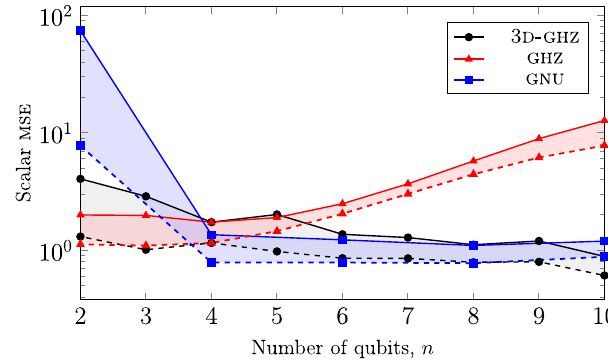
FIG. 5. Estimation precision of two directional components of a FIG. 6. Using Theorem 1, we depict two-sided bounds on the magnetic field B and B with an increasing number of spins in a HCRB for estimating the elements of a magnetic field in a x y depolarizing environment parameterized by g , using modified 3D P depolarizing channel. All plots with depolarizing strength ˆ H θ Þ and n GHZ states. The corresponding Hamiltonian is g ¼ 0 . 3 . This plot compares the performance of 3D GHZ states j ð j ¼ 1 has no interaction terms. With the identity weight matrix, the with n -qubit GHZ states and the permutation-invariant GNU dashed lower lines illustrate the QCRB and the solid lines the states. We observe an interesting crossover point between the upper bound U to the HCRB as given by Theorem 1. tightest bound generated by the n -qubit GHZ states and 3D GHZ states, with an increasing number of qubits. The GNU states are defined over the even number of qubit numbers generates the lowest Holevo bound for a small number of qubits.